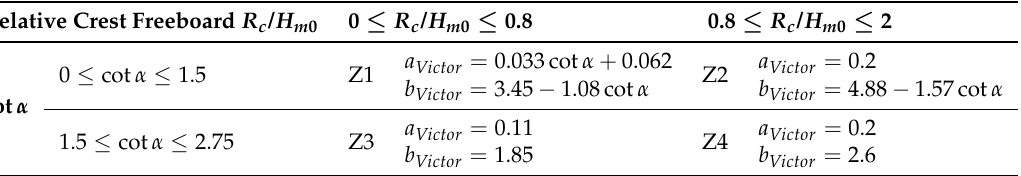
Table 3. Coefficients of Victor and Troch [10] formulae (Equation (2)) as a function of the slope angle α and relative crest freeboard R c / H m 0